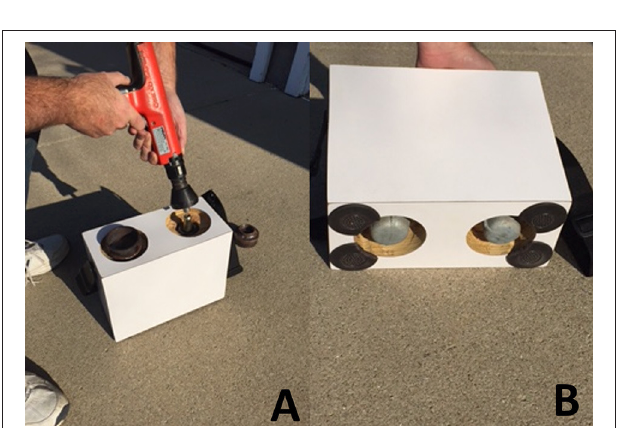
FIGURE 5 | Blood levels of HgB in “slosh,” “no-slosh,” and “control” groups, measured at 2, 4, 24, 48, and 72h post-blast. ‘*’ indicates statistically significant differences at the current time point relative to previous ones.